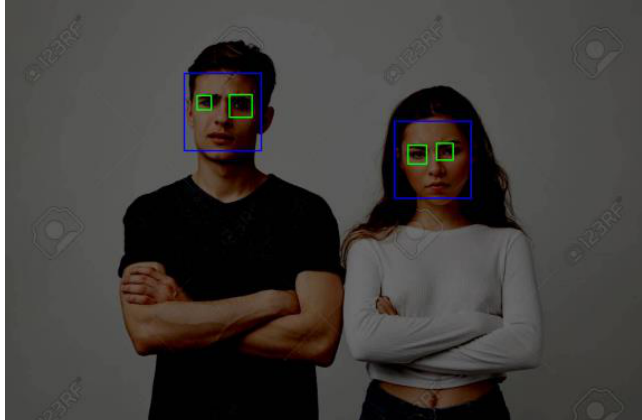
Figure 42. After decreasing the brightness of Figure 40.